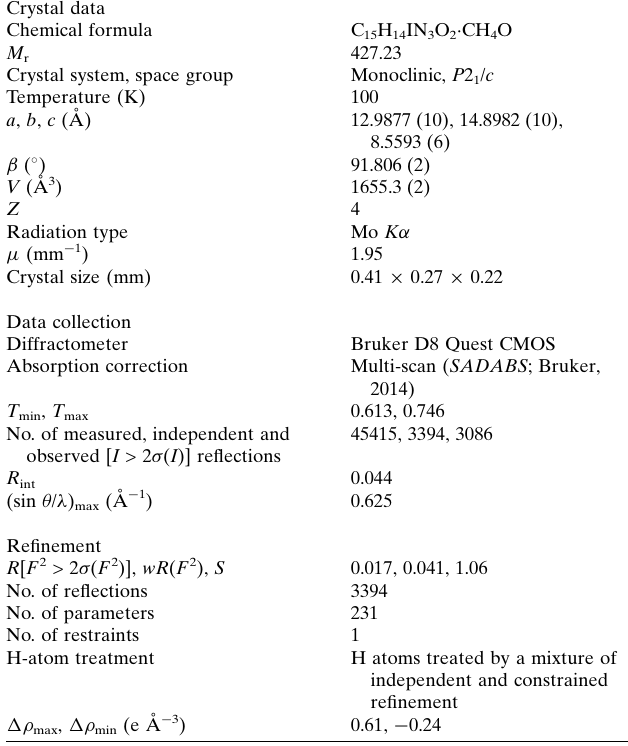
Table 2 Experimental